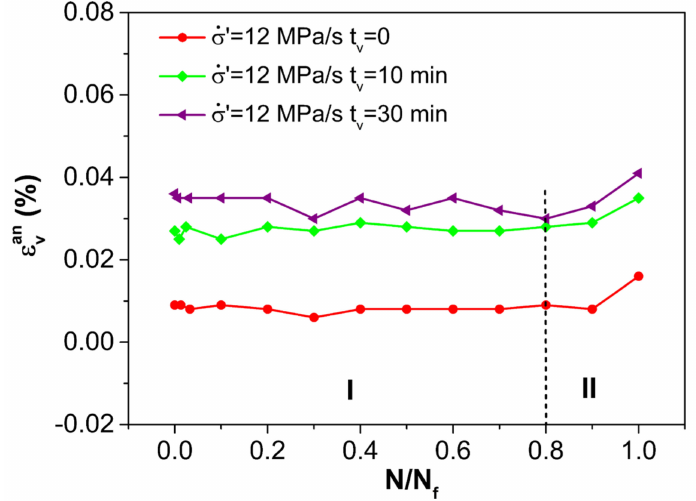
Figure 10. Evolutions of anelastic recovery strain near valley stress ε an v during the entire life for di ff erent durations under valley